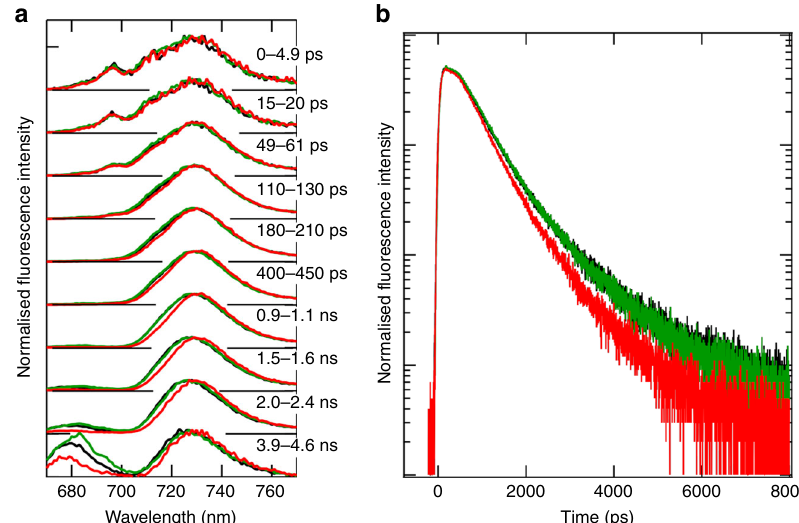
Fig. 5 TRF analyses of the PSI cores. a TRF spectra measured at 77 K excited at 445 nm. The spectra of the PSI tetramer, dimer and monomer are depicted in red, green and black, respectively, and were normalised by the maximum intensity of each spectrum. b Normalised fl uorescence decay curves at 77 K. The decay curves of the PSI tetramer, dimer and monomer are depicted in red, green and black, respectively, and were monitored at 730